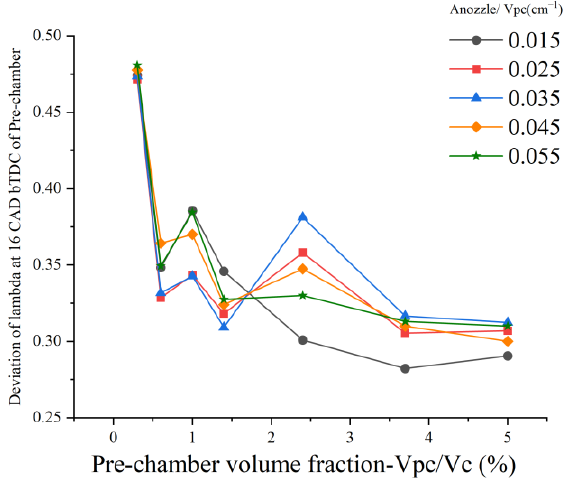
Figure 12. Increase in the mixing ratio in the main chamber.